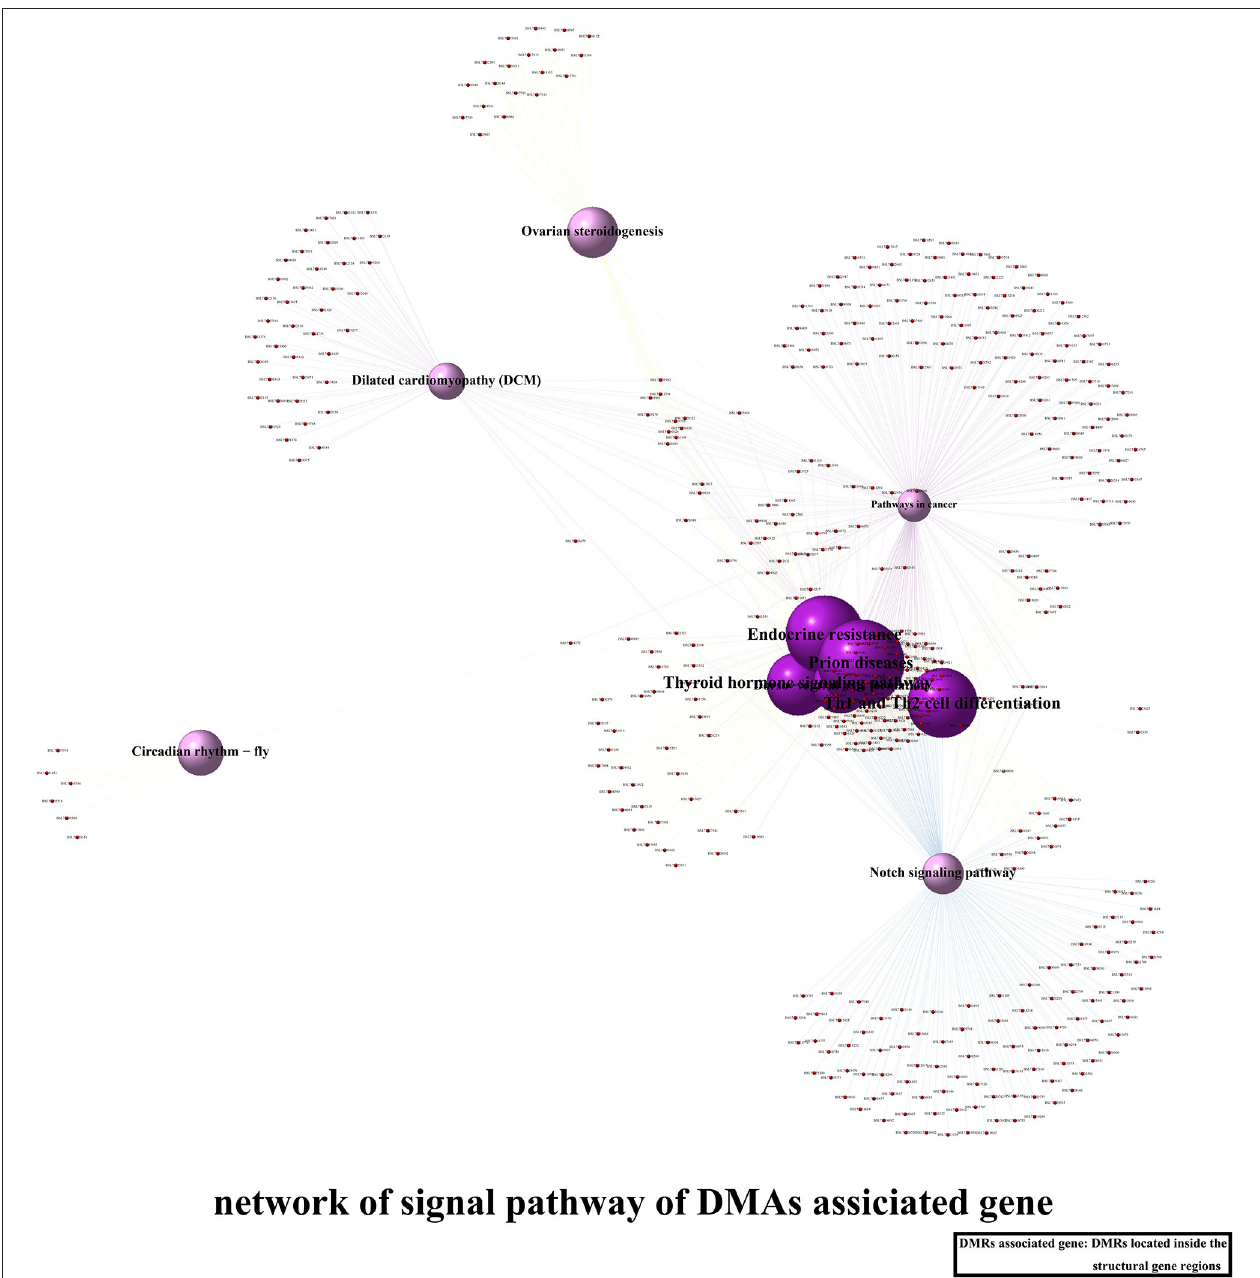
FIGURE 4 | Network of signal pathways via the KEGG enrichment of DMRs associated genes in all of the three treatments groups simultaneously selected from Venn diagram. CRY1a interference groups, ATPase activity was highest in the HT group (883.6 U/mgprot). Among the CRY1b interference groups, ATPase activity was highest in the HL group